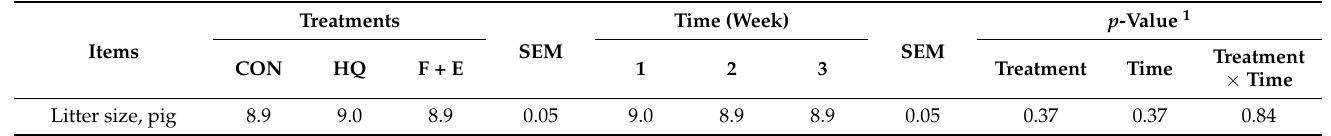
Table 3. Piglet performance and predicted milk